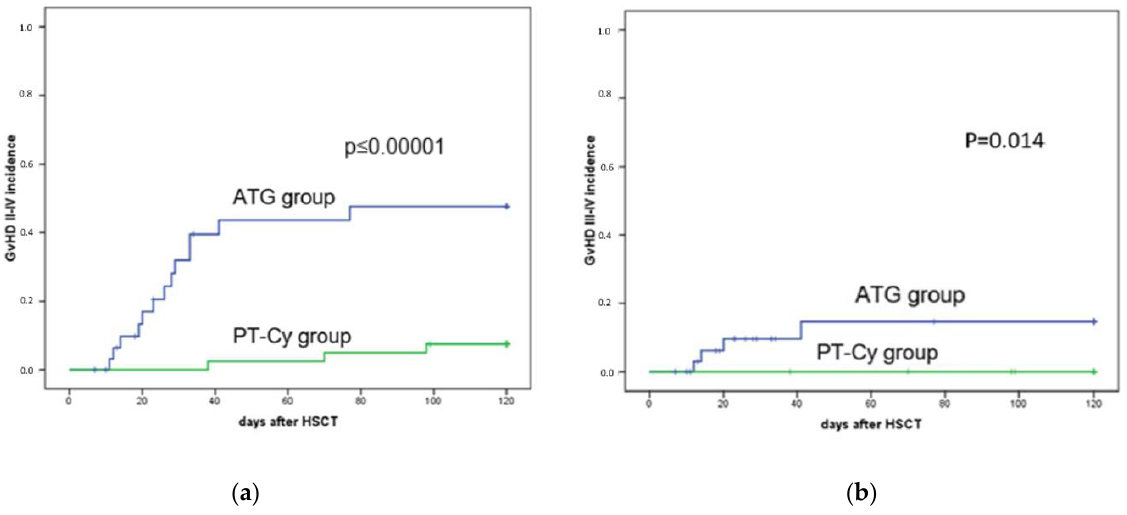
Figure 2. GvHD incidence of day 100 in patients treated with ATG (blue line) and PT-Cy (green line). ( a ) Acute GvHD II–IV incidence after mismatched unrelated donor transplantation was 39% for the ATG group and 7% for the PT-Cy group ( p = 0.0006); ( b ) acute GvHD III–IV incidence after mismatched unrelated donor transplantation was 11% for ATG and 0% for PT-Cy ( p = 0.014). Table 3. Multivariate analysis of factors significantly associated with HSCT outcome. OS = overall survival, TRM = transplant-related mortality, OR = odds ratio, RR= relative risk, ATG = anti- thymocyte globulin, PT-Cy = post-transplant cyclophosphamide, DRI = disease risk index, MAC = myeloablative conditioning, RIC = reduced intensity conditioning, MM = mismatch. The lines in the boxes indicated an absent result. PT-Cy prophylaxis showed a significant value for the GvHD II–IV group in patients more than 60 years old. The RIC conditioning also influenced the GvHD II–IV. The 3-y cGvHD was influenced by PT-Cy and by double MM class 1 and DQB1. The 3-y OS and TRM were influenced by PT-Cy, the patient’s age and also by a high DRI. Table 2. (a) Analysis of day-100 GvHDs following mismatched HSCT; (b) analysis of OS, TRM, RI following mismatched HSCT. Univariate analysis for outcomes. M = male, F = female, ATG = anti-thymocyte globulin, PT-Cy = post-transplant cyclophosphamide, TBI = total body irradiation, RIC = reduced intensity conditioning, MAC = myeloablative conditioning, DRI = disease risk index, MM = mismatch, OS = overall survival, TRM = transplant-related mortality, RI = relapse incidence. (a) DAY-100 (95%